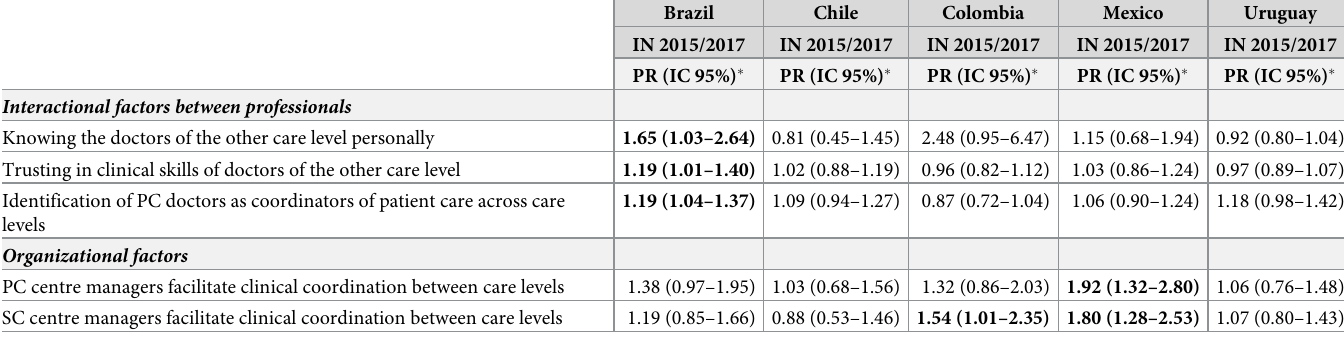
Table 3. Changes in the influencing factors of cross-level clinical coordination (intermediate outcomes) between 2015 and 2017 in the intervention networks of each country.